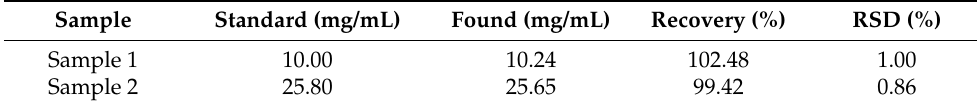
Table 3. Determination of LF in real lactoferrin